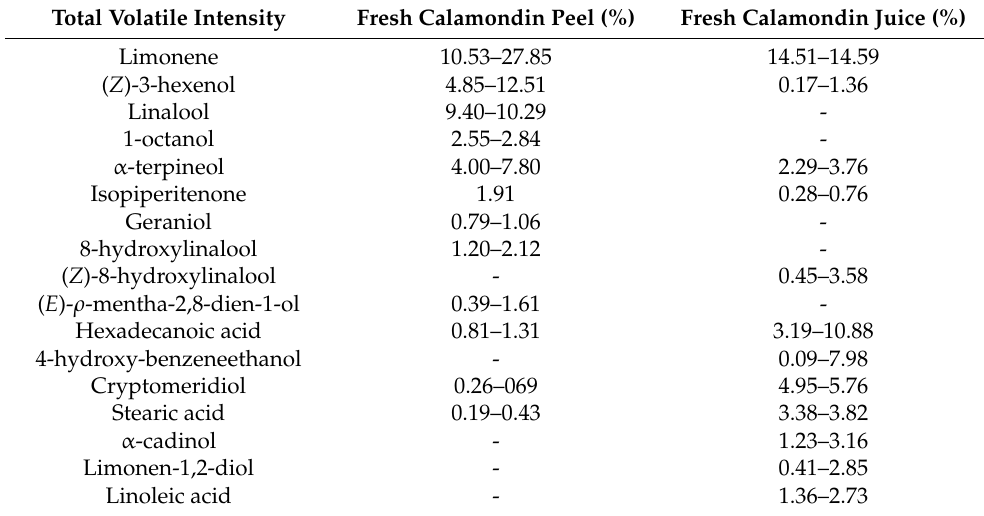
Table 2. Flavor profiles of fresh calamondin peel and juice